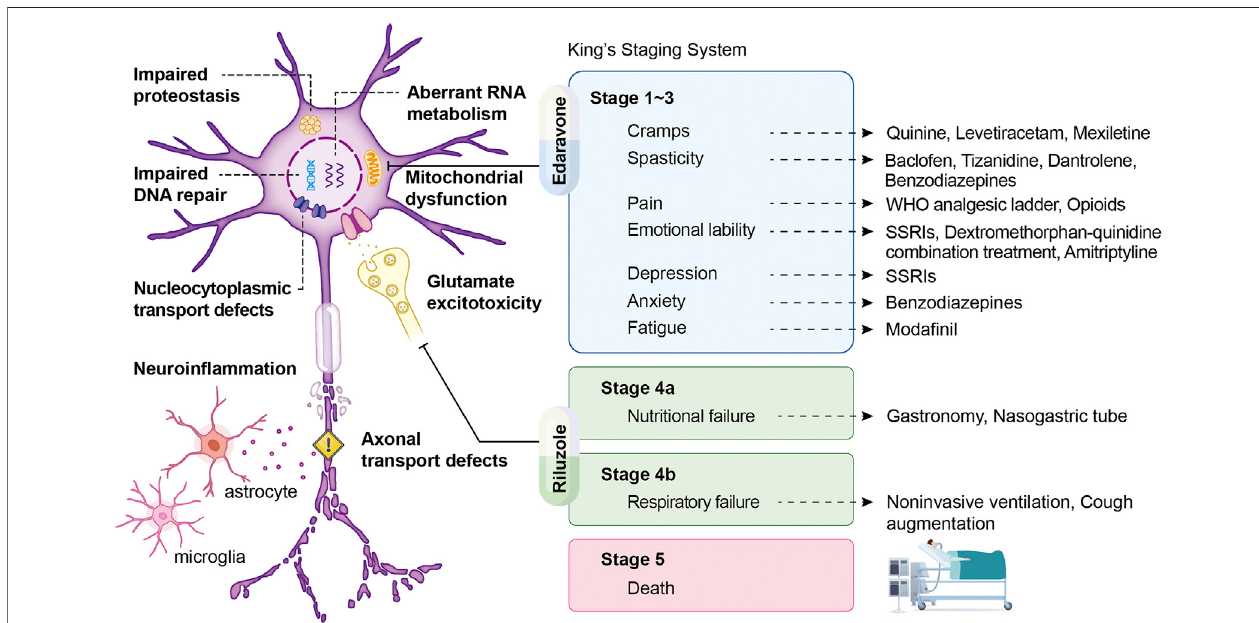
FIGURE 1 | Mechanisms of ALS following treatment to their corresponding symptoms according to King ’ s staging system. Schematic displaying pathology, symptoms, and therapeutic strategies of ALS, with King ’ s staging system being presented as the illustration of disease progression. The arrow derives from each symptompointstoits therapeutic counterparts. Inaddition, twoFDA-approved drugs,edaravoneandriluzole, showconsiderablebene fi tsinstage1 – 3and stage 4and are aiming at mitochondrial dysfunction and glutamate excitotoxicity, respectively.